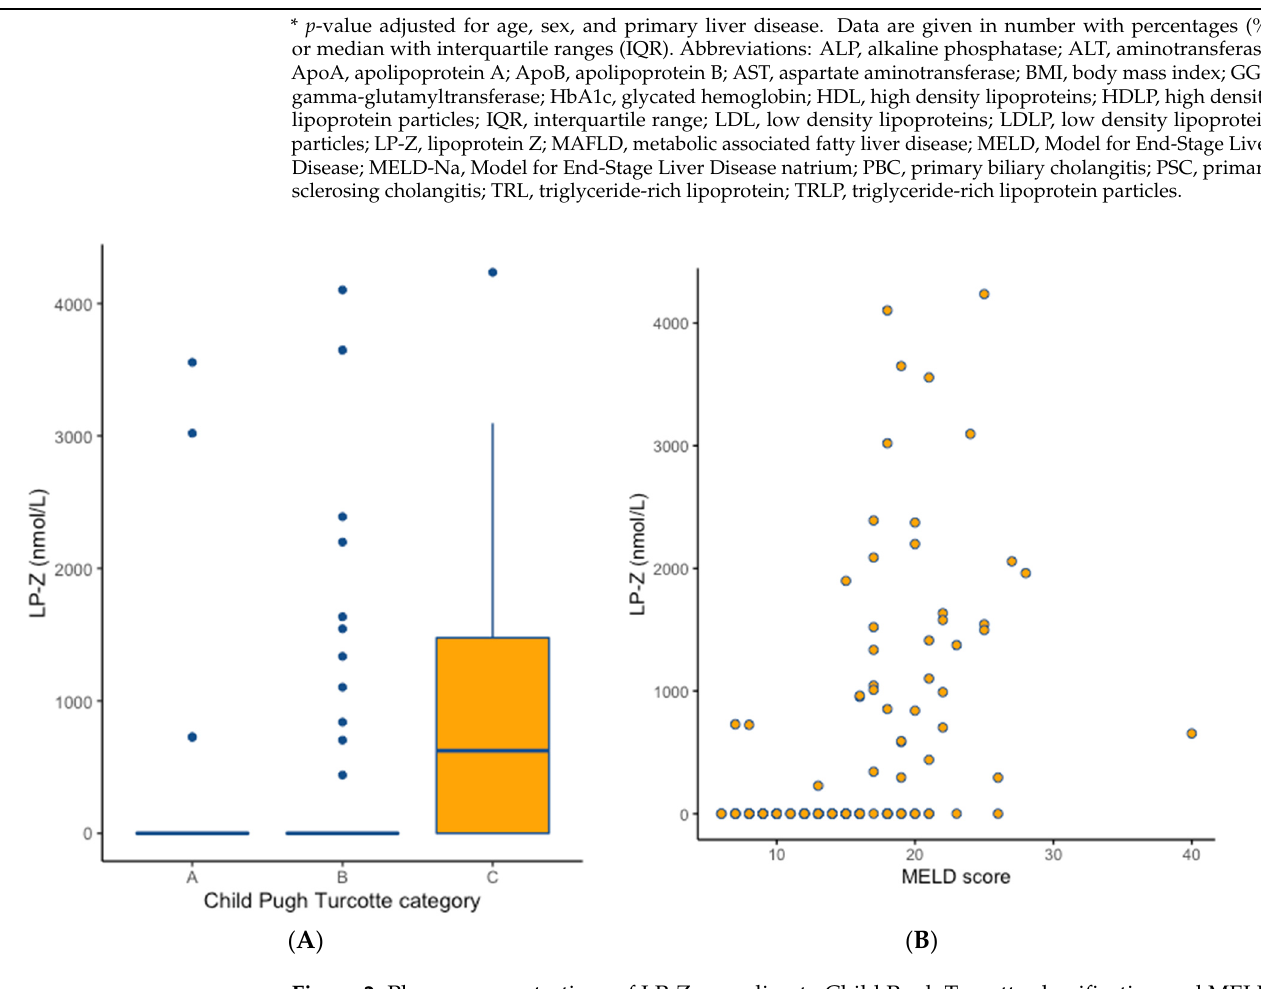
( C ) Figure 3. Boxplot of TRLP, LDLP, and HDLP according to presence of LP-Z in pre-transplant cir- rhotic group (N = 130). Boxplot ( A ): TRLP, Boxplot ( B ): LDLP, Boxplot ( C ): HDLP. p -values were determined by Mann–Whitney U Test. Abbreviations: HDLP, high density lipoprotein particles; LDLP, low density lipoprotein particles; LP-Z, lipoprotein Z; TRLP, triglyceride-rich lipoprotein particles.